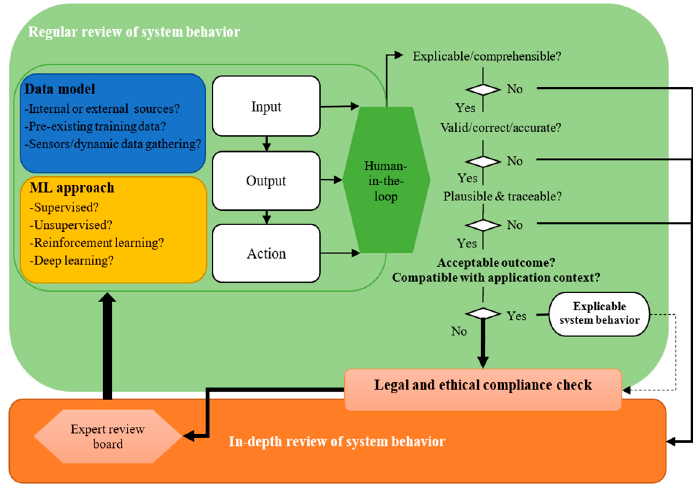
Figure 2. Draft heuristic model to assess deep automation bias.